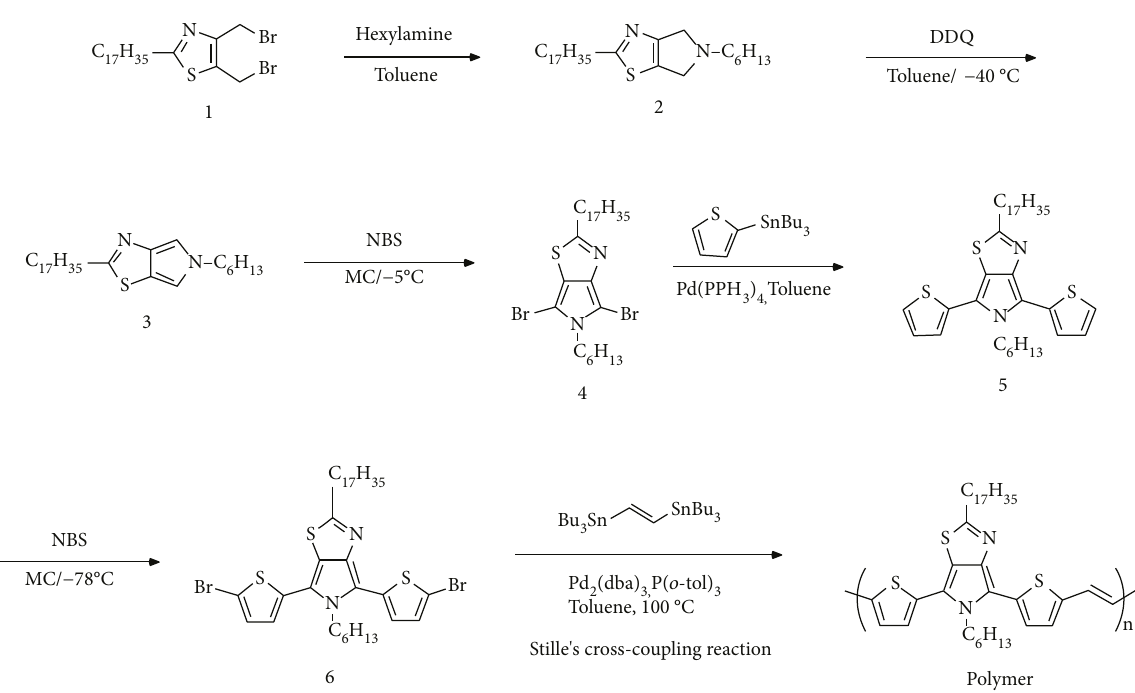
Figure 1: Schematic representation for the synthesis of new conducting